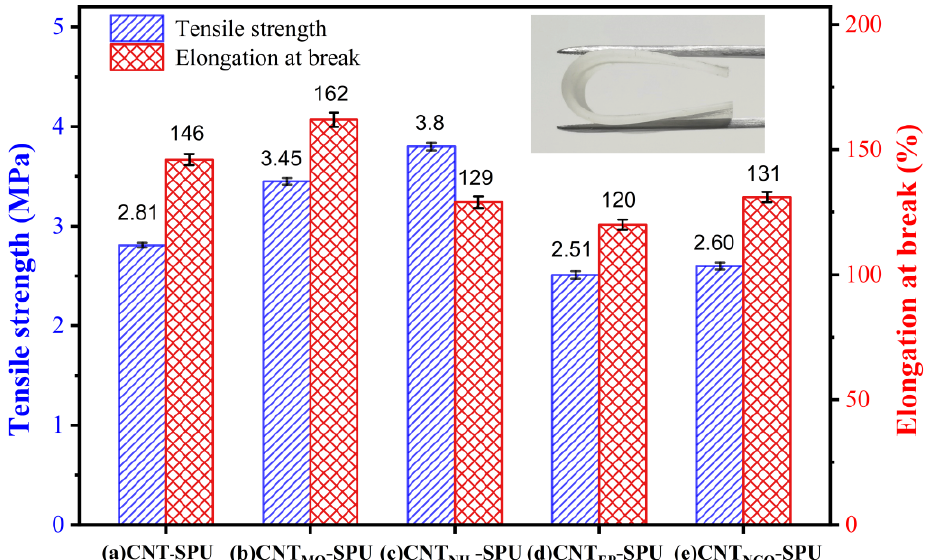
Figure 7. Mechanical properties of CNT-SPU composite free-standing film before and after modification: ( a ) CNT-SPU , ( b ) CNT MO -SPU , ( c ) CNT NH2 -SPU , ( d ) CNT EP -SPU , ( e ) CNT NCO -SPU . The insert in the upper right corner is the photo of CNT MO -SPU free-standing film.